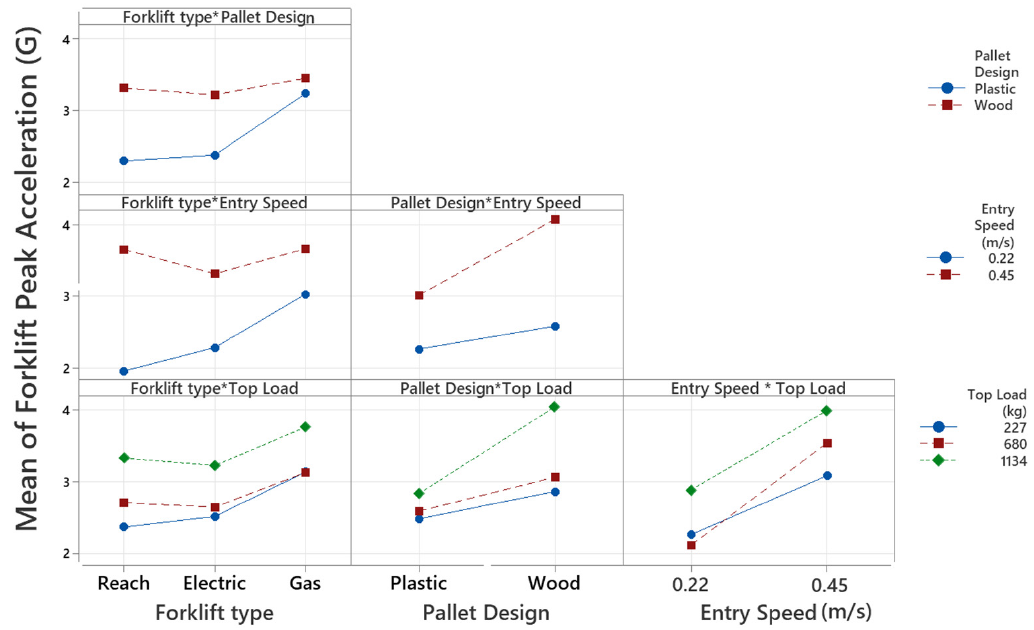
Figure 5. Interaction plot for Forklift Peak Acceleration response.